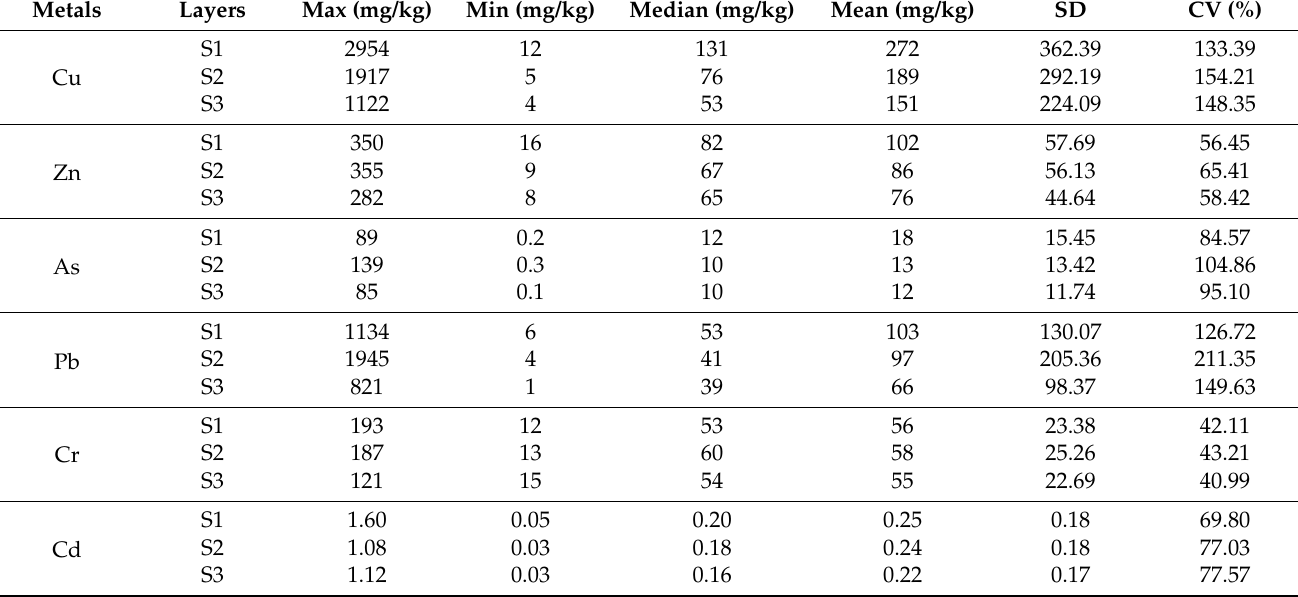
Table 2. Test results of soil heavy metals in the study